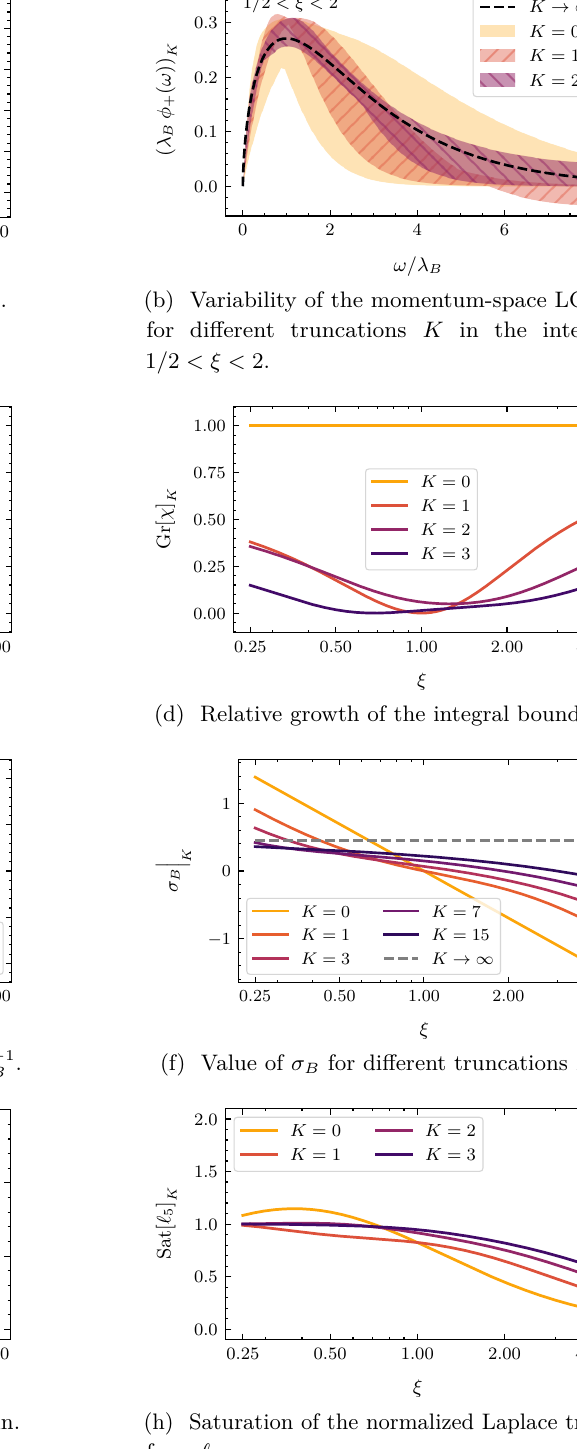
(h) Saturation of the normalized Laplace trans- form ‘ 5 . , plotted on a logarithmic 0 /λ B